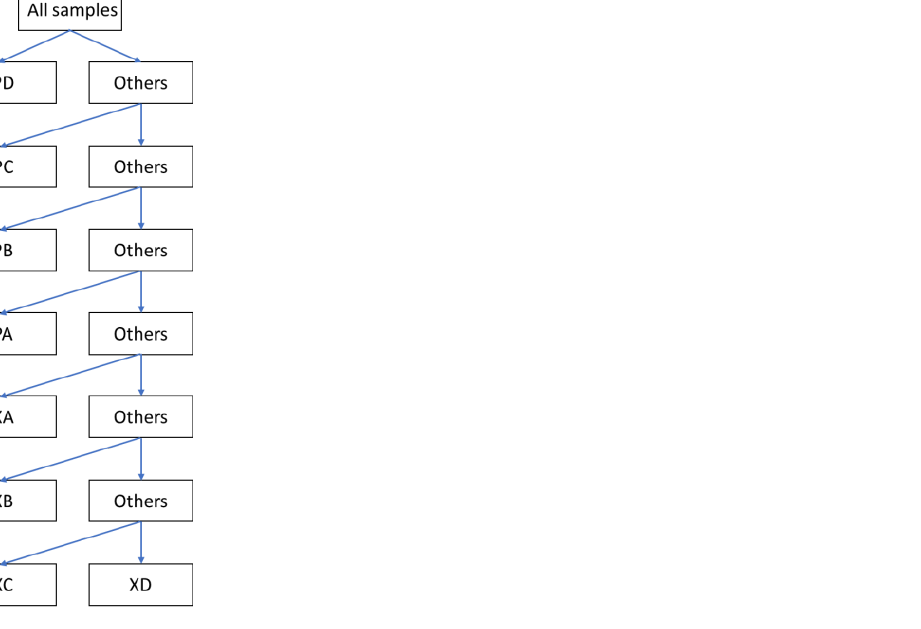
Figure 6. Scheme of the classification tree based on successive two-class classification models until all the samples are separated. Sample class acronyms are defined in Figure 5.